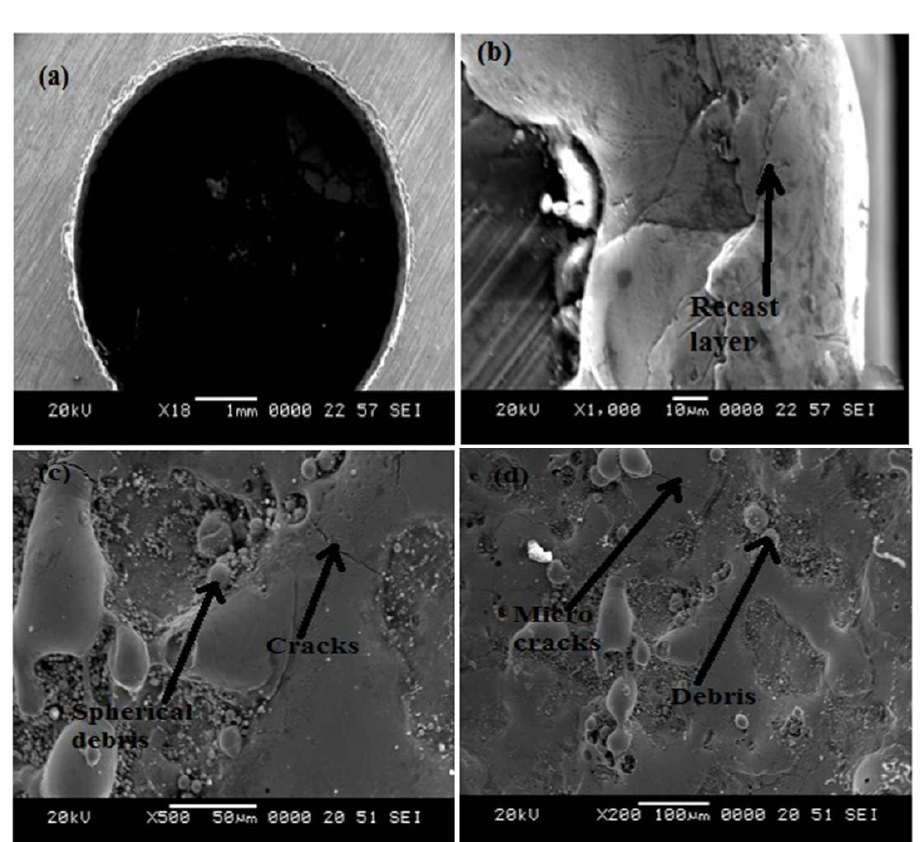
Figure 12: SEM micrograph: Exp No. 1; at T on = 30 µ s; T off = 30 µ s; I p = 6